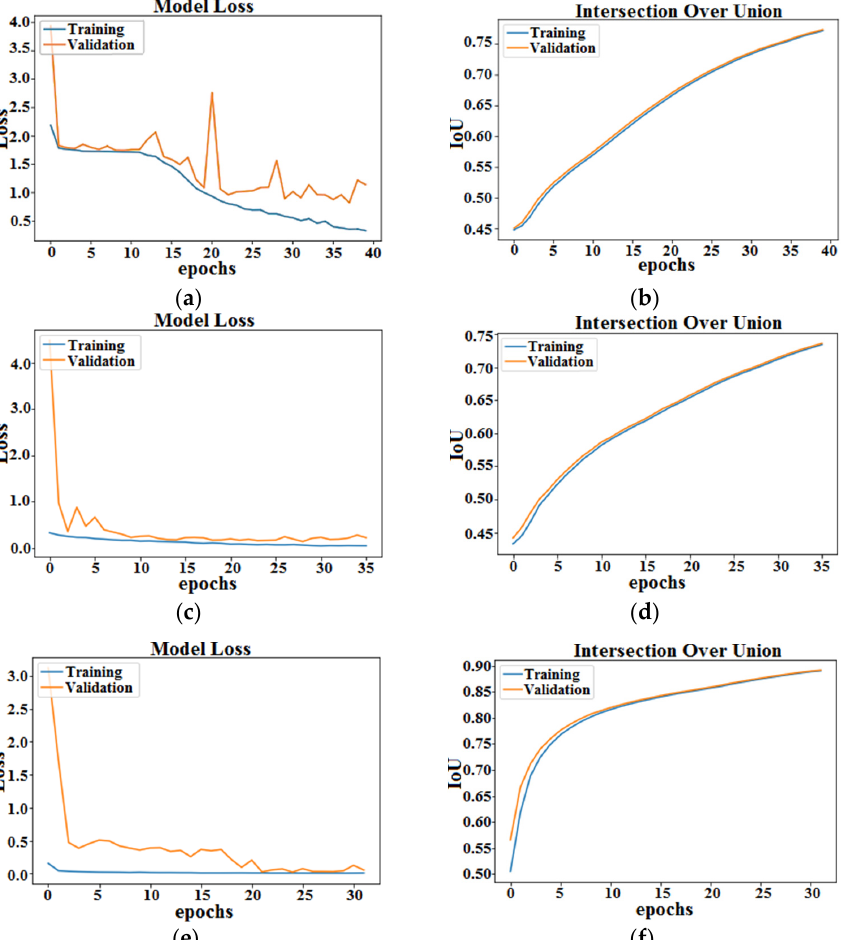
Figure 6. Summarized history for: ( a ) Loss of U ‐ Net, and ( b ) Intersection over Union (IoU) of U ‐ Net ( c ) Loss of AID ‐ U ‐ Net (3, 1), and ( d ) IoU of AID ‐ U ‐ Net (3, 1), ( e ) Loss of AID ‐ U ‐ Net (2, 2), and ( f ) IoU of AID ‐ U ‐ Net (2, 2). Table 3. Comparative Results between U ‐ Net with depth 4, AID ‐ U ‐ Net (3, 1) and AID ‐ U ‐ Net (2, 2), applied to optical colonoscopy images of CVC ‐ ClinicDB for colorectal polyp segmentation. Evaluation Metrics